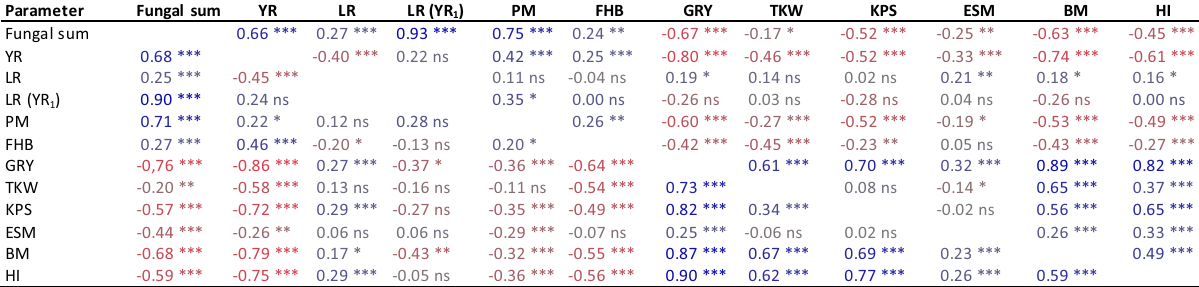
Table 3. Correlation matrix for fungal diseases (YR, LR including subgroup of LR with low YR infestation, PM, FHB), yield (GRY) and yield components (TKW, KPS, ESM, BM, HI) based on LSmeans (observations over years and repeats) at two N rates, with 110 kg N ha −1 above diagonal and 220 kg N ha −1 below diagonal. Colours indicate degree and direction of correlation. Fungal sum, YR + LR + PM + FHB; YR, stripe rust; LR, leaf rust; LR (YR 1 ), leaf rust at quantile class with YR < 4.0455%; PM, powdery mildew; FHB, Fusarium head blight; GRY, grain yield; TKW, 1000 kernel weight; KPS, kernels per spike; ESM, stand density/m 2 ; BM, aboveground biomass; HI, harvest index; Signif. p, significance level of p value: *** < 0.001, ** < 0.01, * < 0.05, ns not significant.